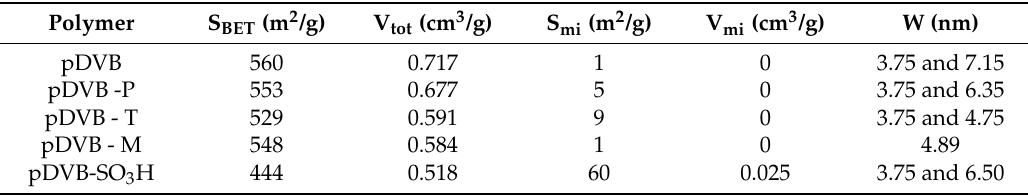
Table 3. The porous structure parameters.